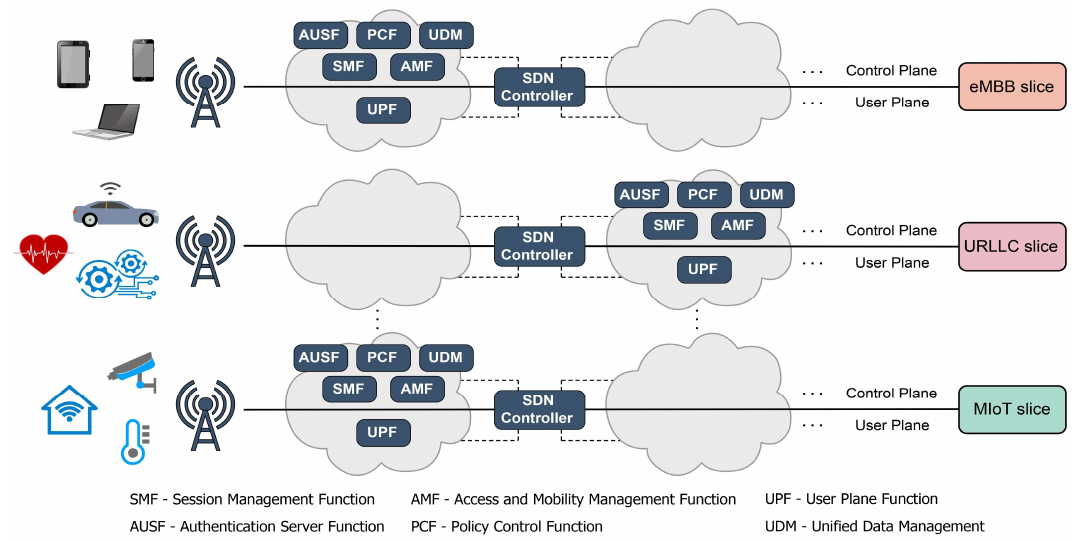
Figure 10. Control and user plane separation supported through network slicing.